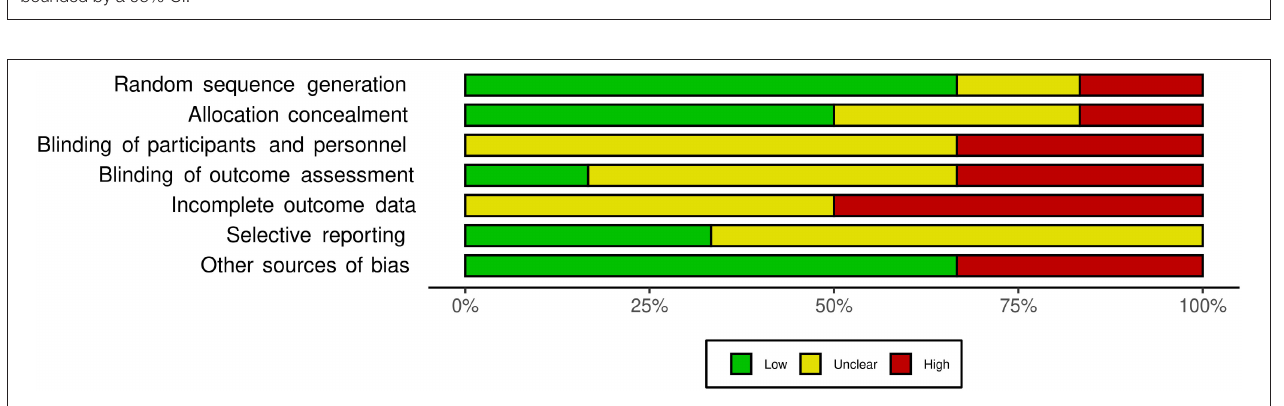
FIGURE 5 | Summary of the risk of bias assessment using the Cochrane Risk for bias (RoB)